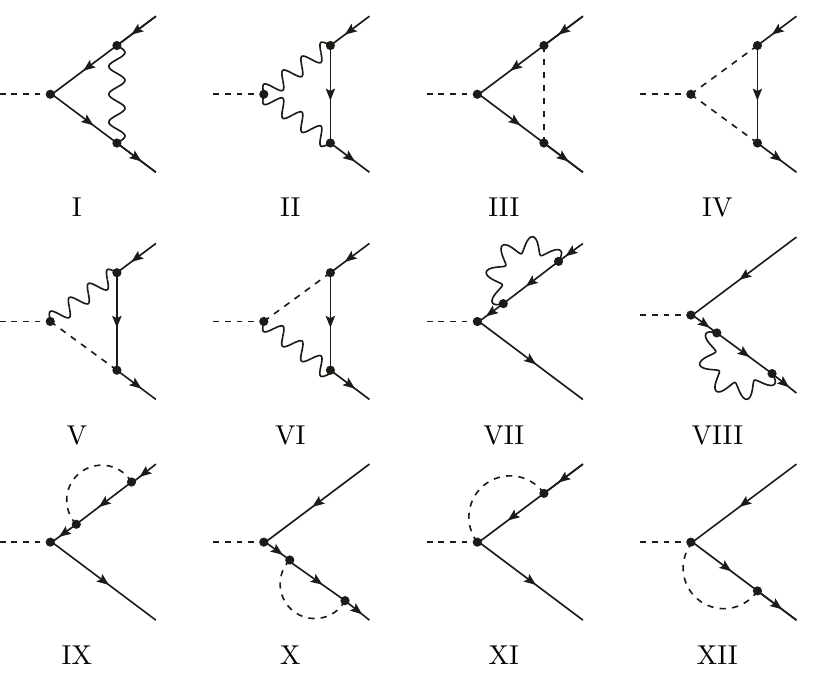
Figure 1 . Topologies contributing to h ! ‘‘ 0 .